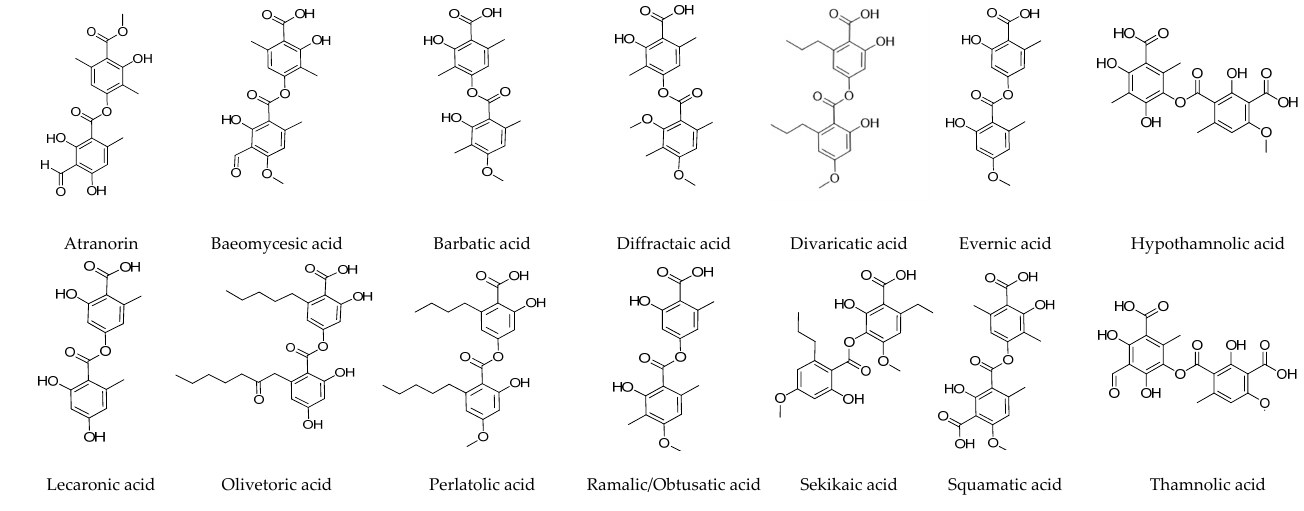
Figure 1. Chemical structures of different depsides of lichens. Table 1. Pharmacological activity of lichen